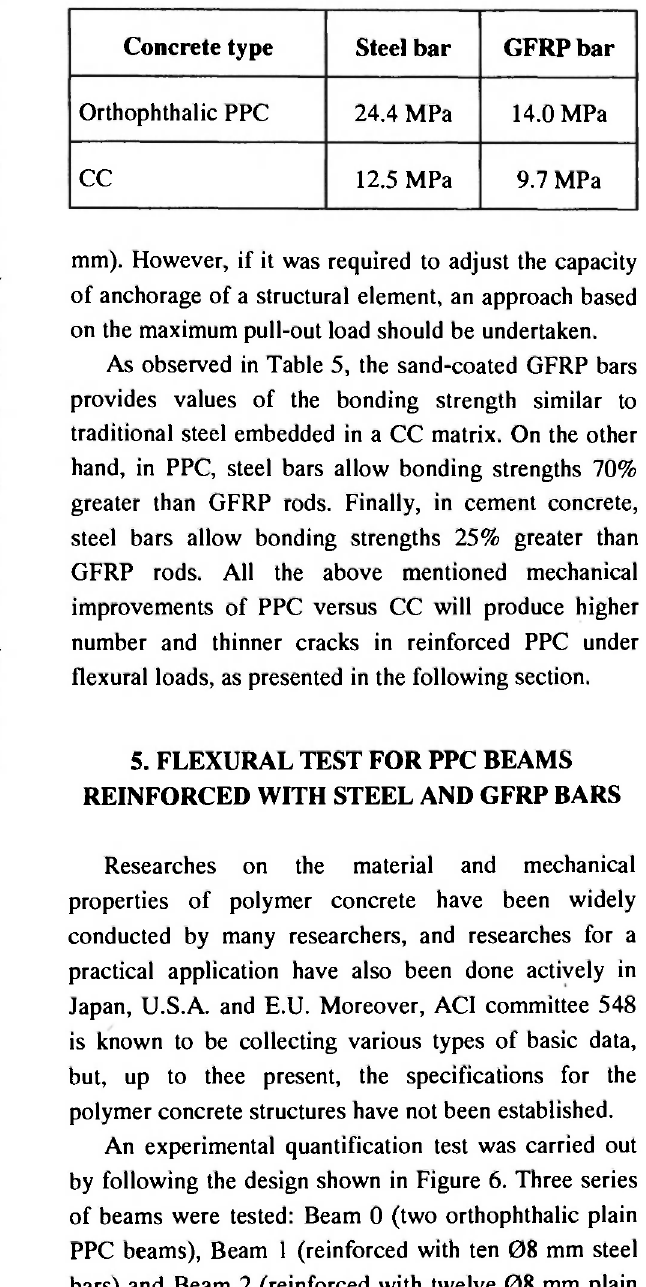
Experimental monotonic bond strength